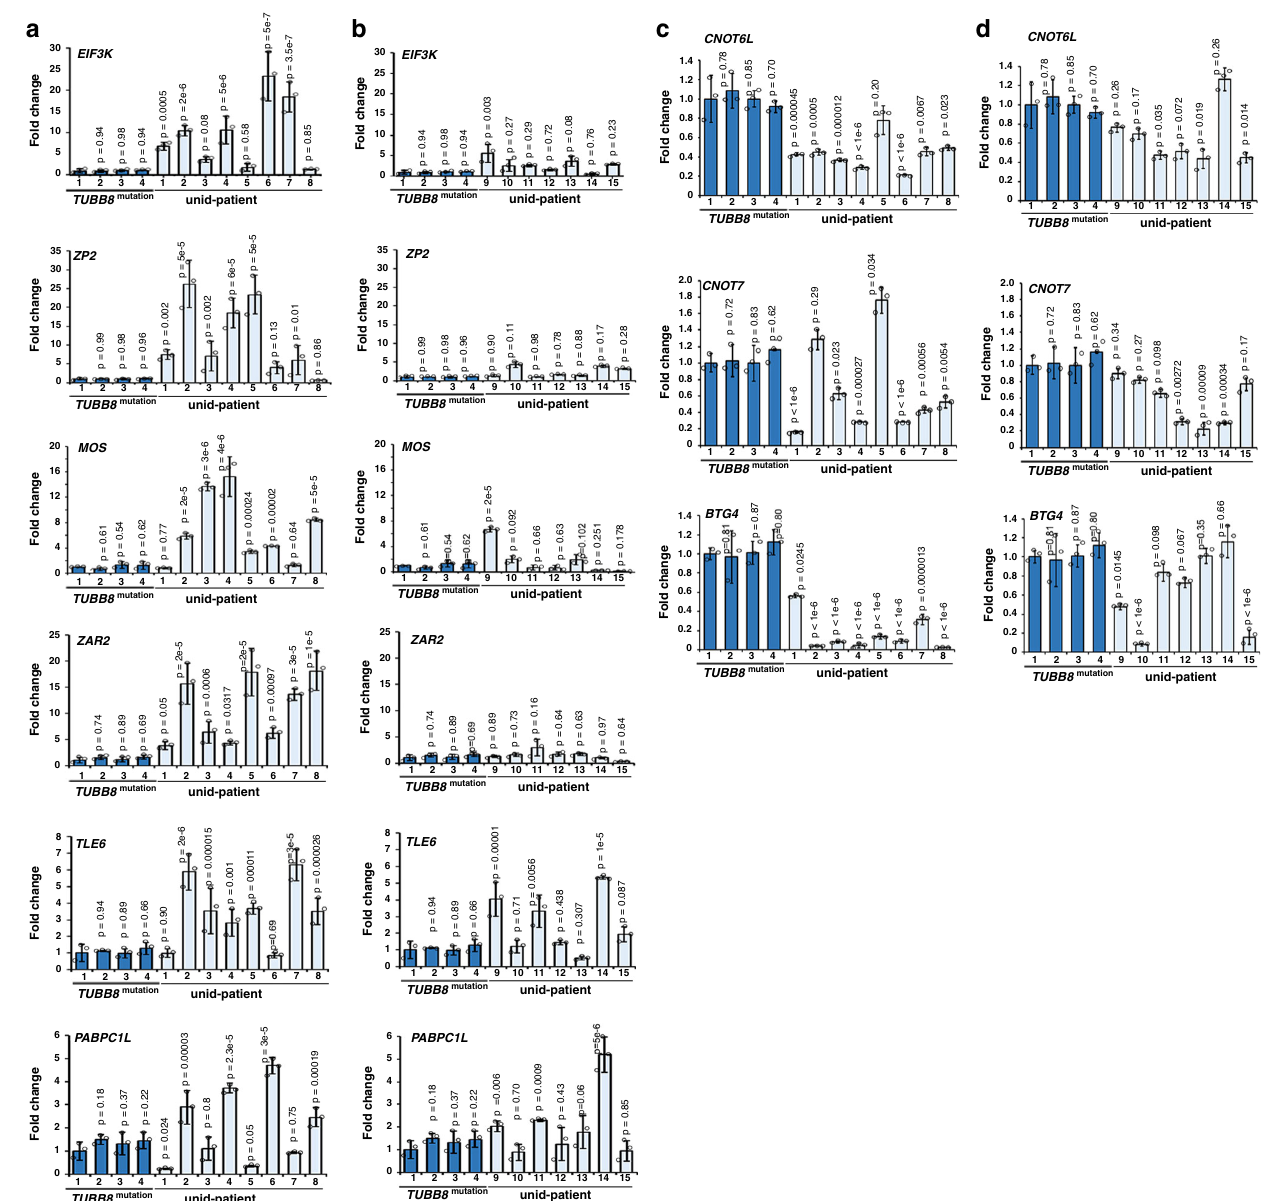
Fig. 7 Levels of maternal transcripts in development-arrested human zygotes. a and b RT-qPCR results showing the mRNA levels of selected M-decay transcripts in arrested zygotes derived from TUBB8 -mutated and unid-patients 3 days after IVF. c and d RT-qPCR results showing the mRNA levels of BTG4 , CNOT7 , and CNOT6L in arrested zygotes that were derived from TUBB8 -mutated and unid-patients. Data are presented as mean values ± SEM. P value by one-way ANOVA. n = 3 independent